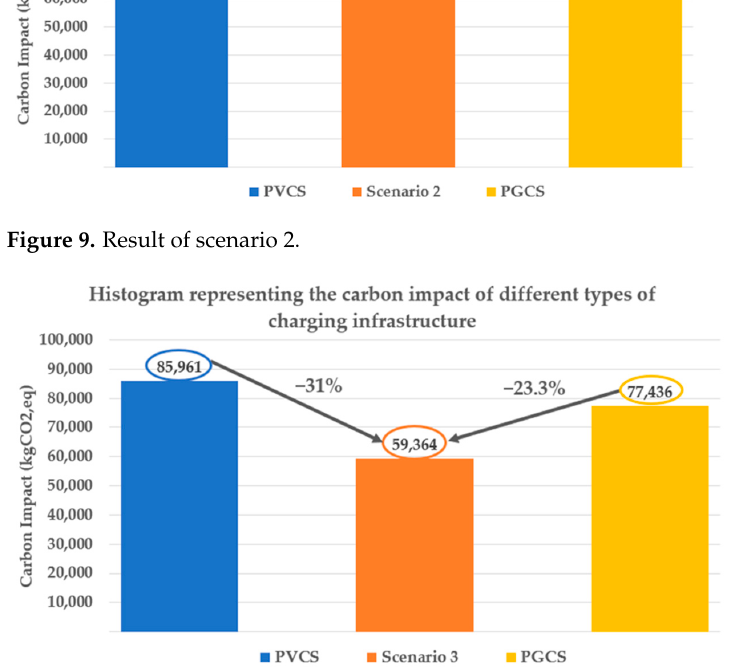
Figure 10. Result of scenario 3.